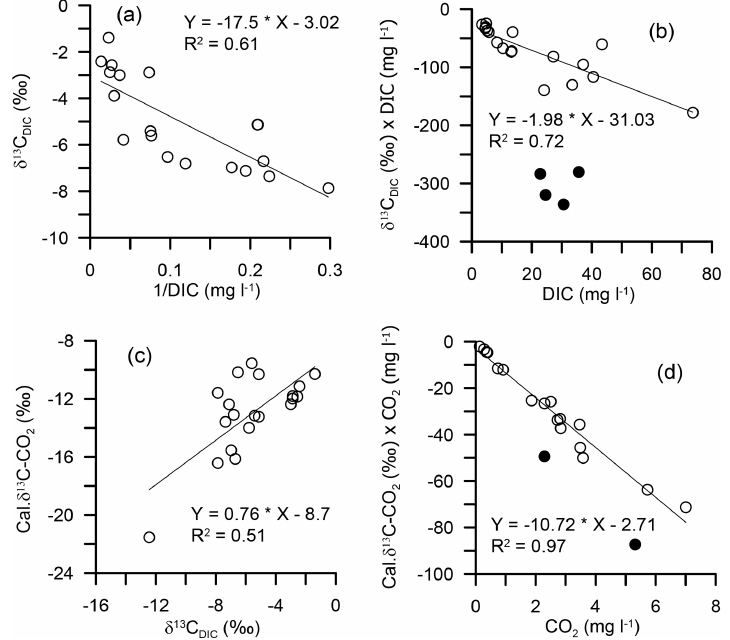
Figure 5. Linear least-squares regression models of (a) δ 13 C DIC as a function of 1/DIC (Keeling plot) and (b) δ 13 C DIC xDIC as a function of DIC concentrations (Miller–Tans plot) in the Indian monsoonal rivers. (c) Linear relationship between calculated δ 13 C of CO 2 and the measured δ 13 C DIC values, and (d) Miller–Tans linear regression model of δ 13 C-CO 2 × CO 2 as a function of CO 2 concentration in the Indian monsoonal